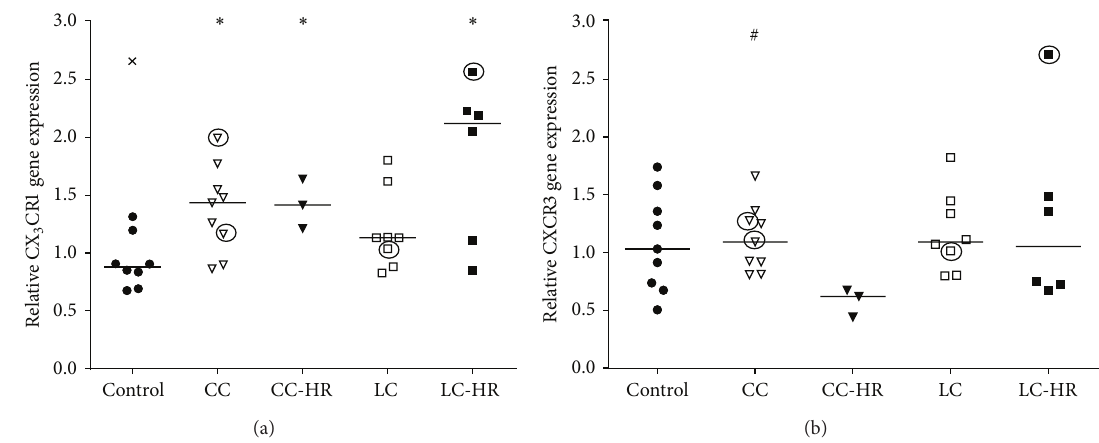
Figure 3: Relative gene expressions of the chemokine receptors CX 3 CR1 and CXCR3. Each symbol represents one patient, and the medians are depicted as a line. Statistical outliers are marked as crosses (X) and budesonide treated patients are encircled. ∗ 𝑃 < 0.05 versus controls and # 𝑃 < 0.05 versus